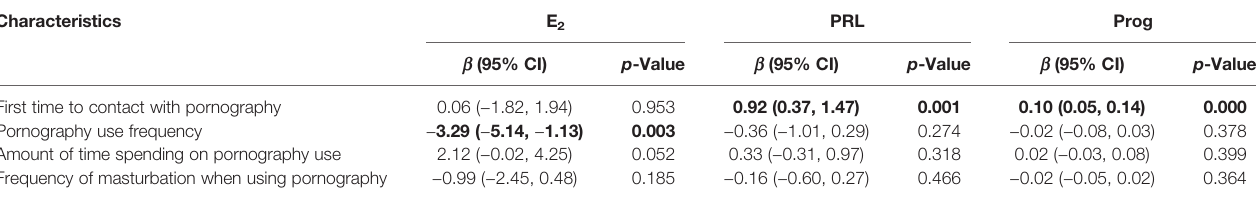
TABLE 4 | Associations between pornography use and serum gonadal hormone levels.